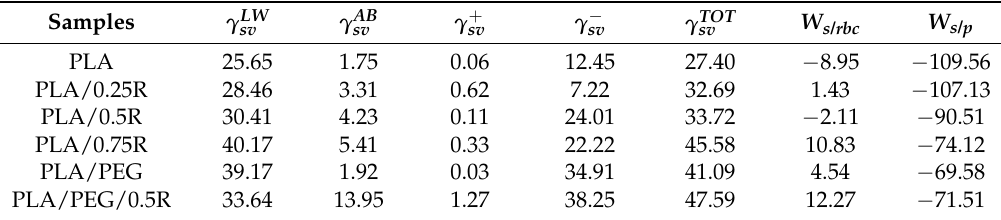
Table 11. Surface tension parameters (mN/m) and work of spreading for red blood cells and platelets of composites